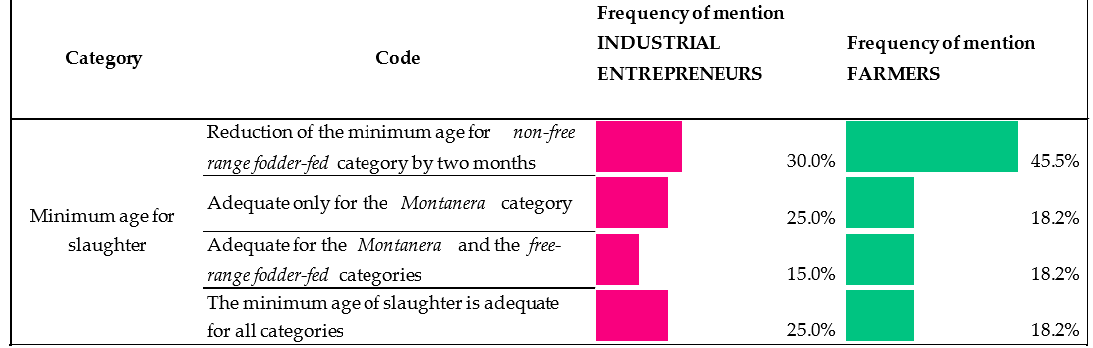
Figure 5. Industrial entrepreneur/farmer views on the QS (Quality Standard) requirements for age of slaughter (Scale: frequency of mention of each opinion. Percentage is based on responses in the given code out of all responses to equal 100%) .